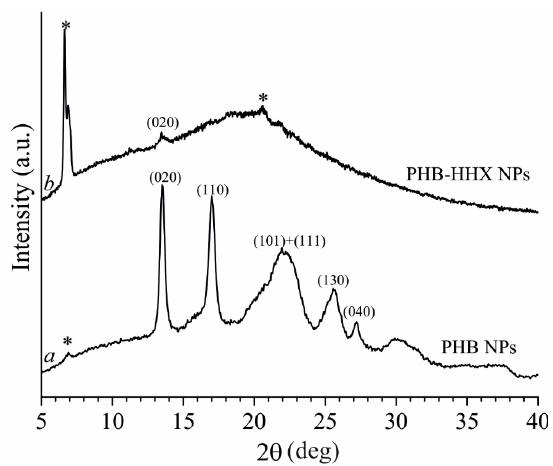
Figure 4. X-ray powder diffraction profiles of the EO-loaded nanoparticles PHB NPs ( profile a ) and PHB-HHx NPs ( profile b ). The diffraction of residual SDS crystals is marked (*). In the case of the PHB-HHx sample, the typical broad halo of the amorphous is observed in the diffraction profile b of Figure 4 along with the presence of (020) reflection at 2 θ = 13° with very low intensity indicating that only traces of crystallinity are detected